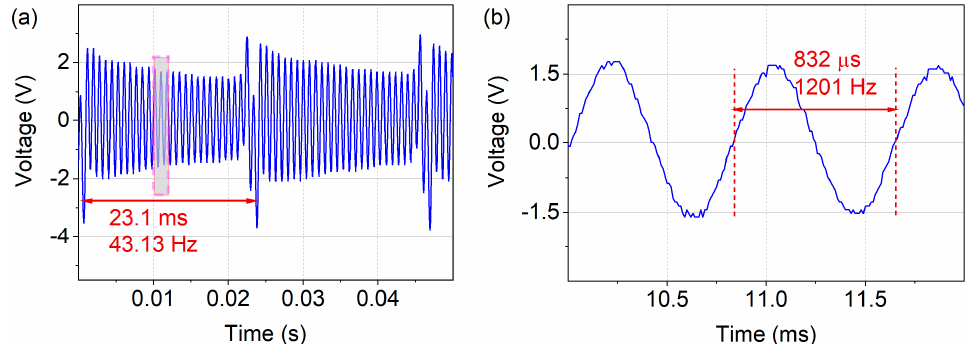
Figure 6. ( a ) Open circuit voltage output of V PP ≈ 3–4 V in magnetic frequency up-conversion exci- tation at f exc = 43.13 Hz. ( b ) The harvester oscillates at f res = 1201 Hz in between the excitation events.